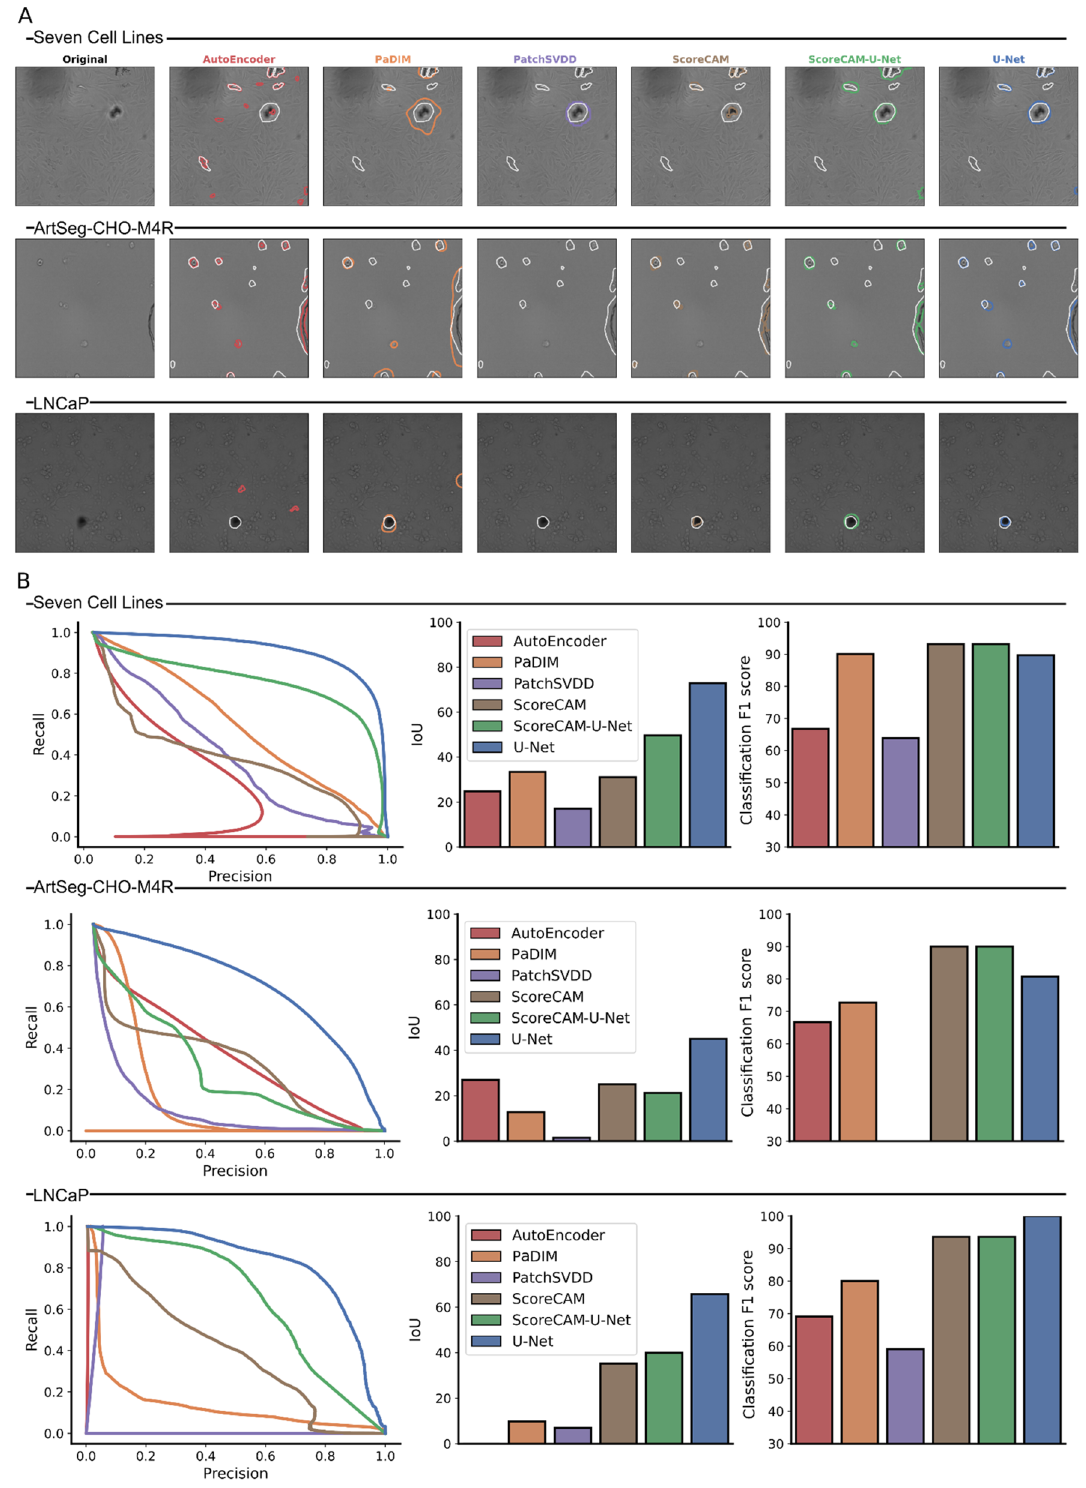
Figure 3. Artifact segmentation and image-level classification results for all models (colors) in seven cell lines, LNCaP, and ArtSeg-CHO-M4R datasets. ( A ) Examples of brightfield images and the corresponding artifact segmentation of all models (columns, colors) and datasets (rows; separated by lines and dataset names). White contour: expert annotated artifact boundaries; colored contours: artifact segmentation boundaries of the corresponding model. ( B ) Different performance metrics for all models (colors) and datasets (rows). Left column: artifact segmentation precision (x-axis) and recall (y-axis) of artifact detection at different thresholds (points along the curve) for all models and datasets. Middle column: artifact segmentation pixel-wise IoU (y-axis) for all models and all datasets. Right column: image-level classification F1 score (y-axis) for all models (x-axis) and datasets